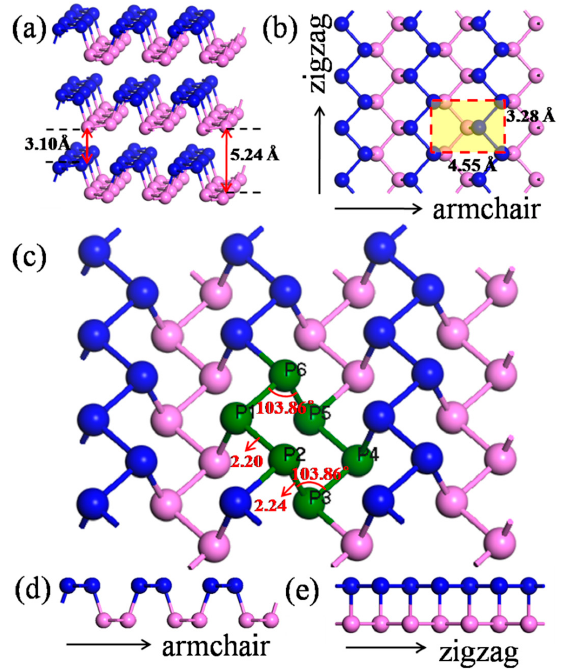
Figure 1. The structures of black phosphorus (BP): ( a ) bulk BP; ( b ) top view of monolayer BP; ( c ) computing unit of the puckered orthorhombic lattice; ( d ) side view from the armchair direction; and ( e ) side view from zigzag direction. Atoms in the top and bottom layers are in blue and pink, respectively.